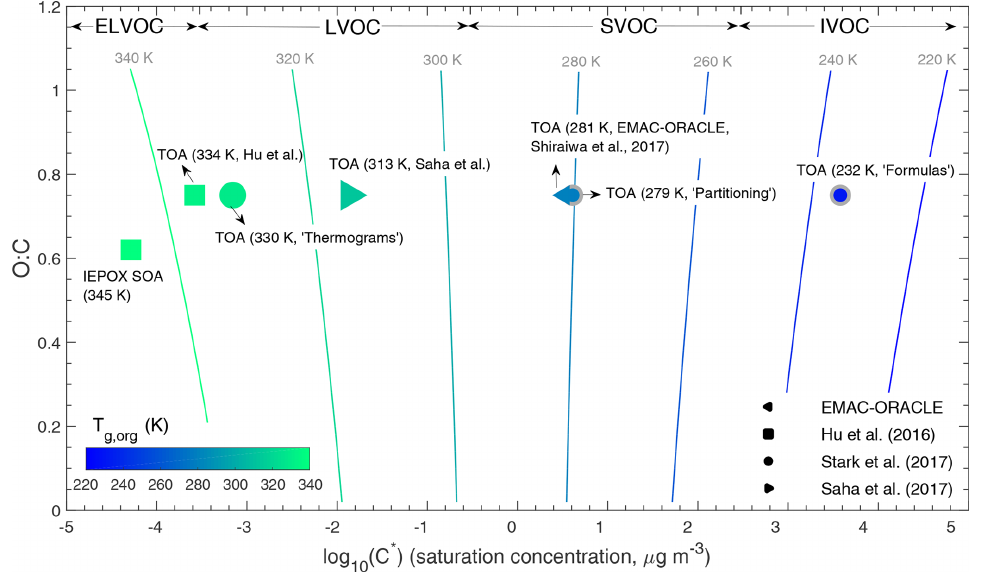
Figure 2. Predicted glass transition temperatures of organic aerosols under dry conditions ( T g , org ) during the SOAS campaign placed into the 2-D VBS framework. The isopleths correspond to the T g calculated using Eq. (1) with the effective saturation mass concentration ( C ∗ ) and the O : C ratio defined in the 2D-VBS. The markers represent the T g , org of total OA (TOA) and IEPOX SOA calculated from the volatility distributions simulated by a global chemical transport model (EMAC-ORACLE; Shiraiwa et al., 2017) or measured during the SOAS campaign (Hu et al., 2016; Saha et al., 2017; Stark et al., 2017). Three methods ( Formulas , Partitioning , and Thermograms ) are applied in Stark et al. (2017) to derive the C ∗ distributions, where the Thermograms method provides the most credible volatility distributions compared to Formulas and Partitioning (marker edge lines in